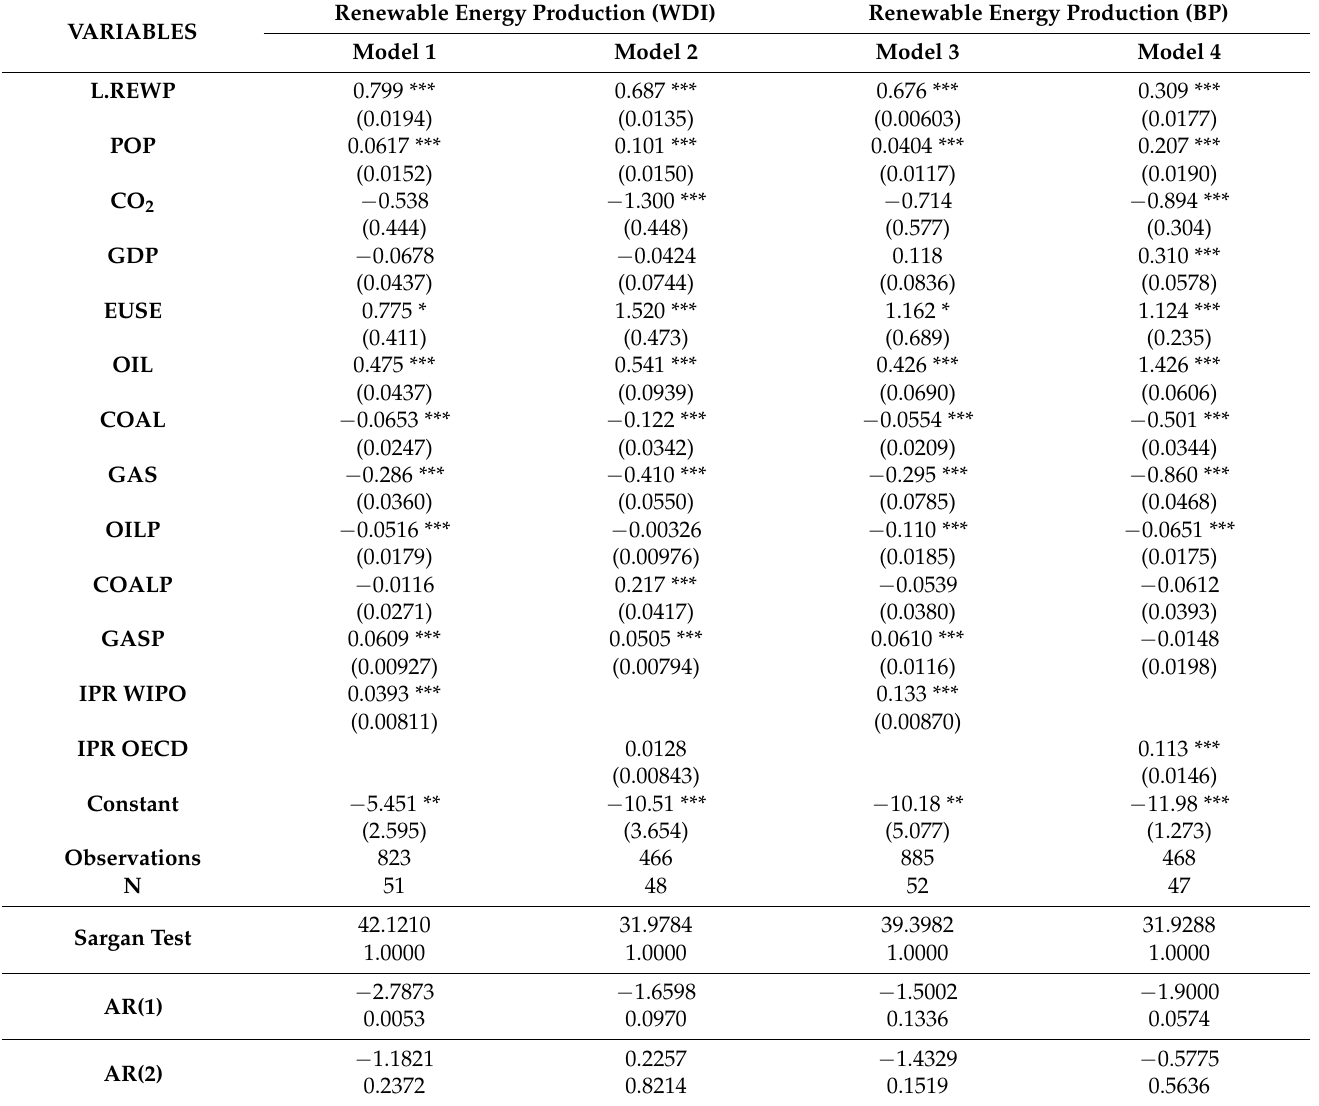
Table 2. Results of dynamic panel estimations for intellectual property rights and renewable energy production.